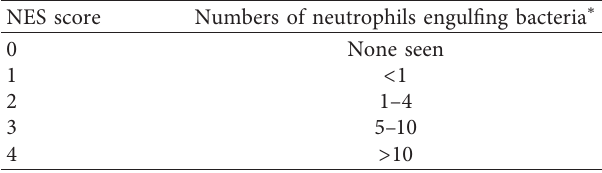
Table 2: Severity of neutrophil engulfing bacteria scores (NESs).